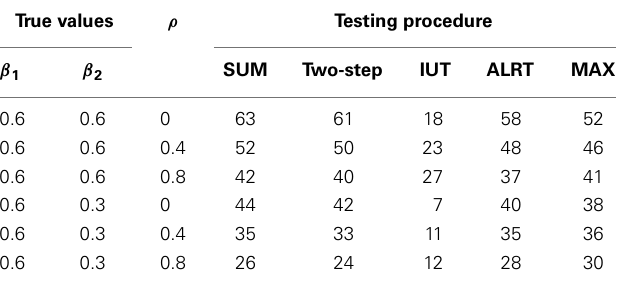
Table 4 | Simulation results: power (%) under different correlation between outcomes.